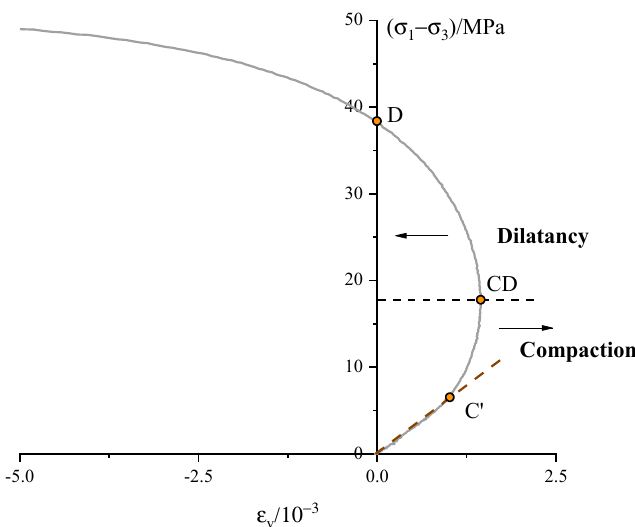
Figure 4. Volumetric strain versus deviatoric stress curve under uniaxial compression.